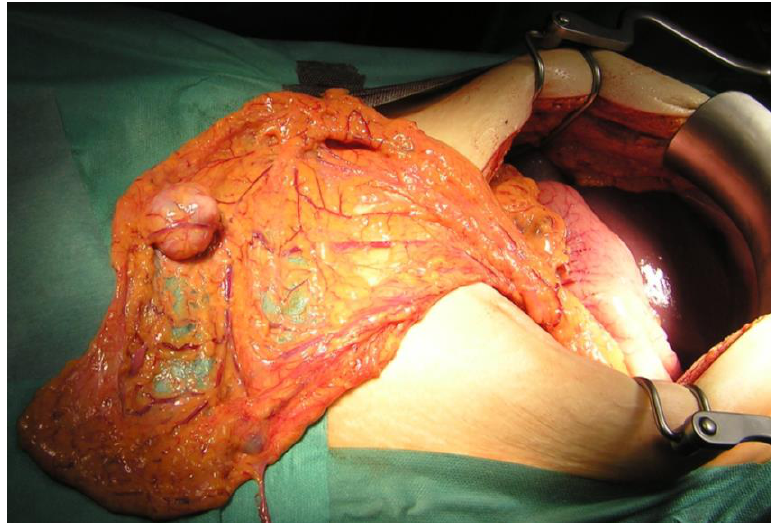
Figure 1. Isolated peritoneal metastasis in greater omentum (P1).